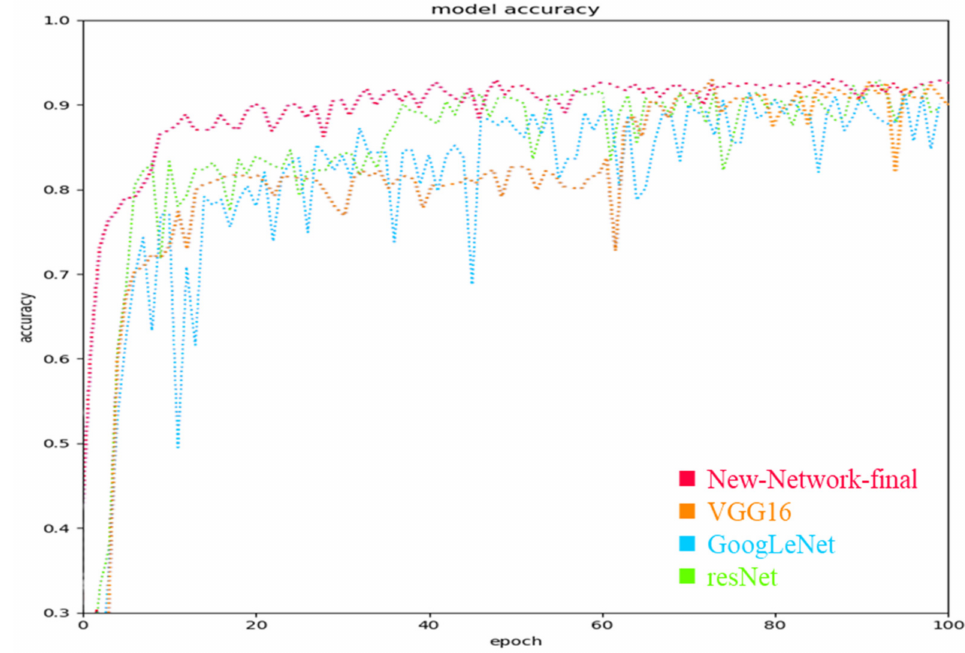
Figure 16. Comparison of testing accuracy in various models. Appl. Sci. 2021 , 11 , 8226